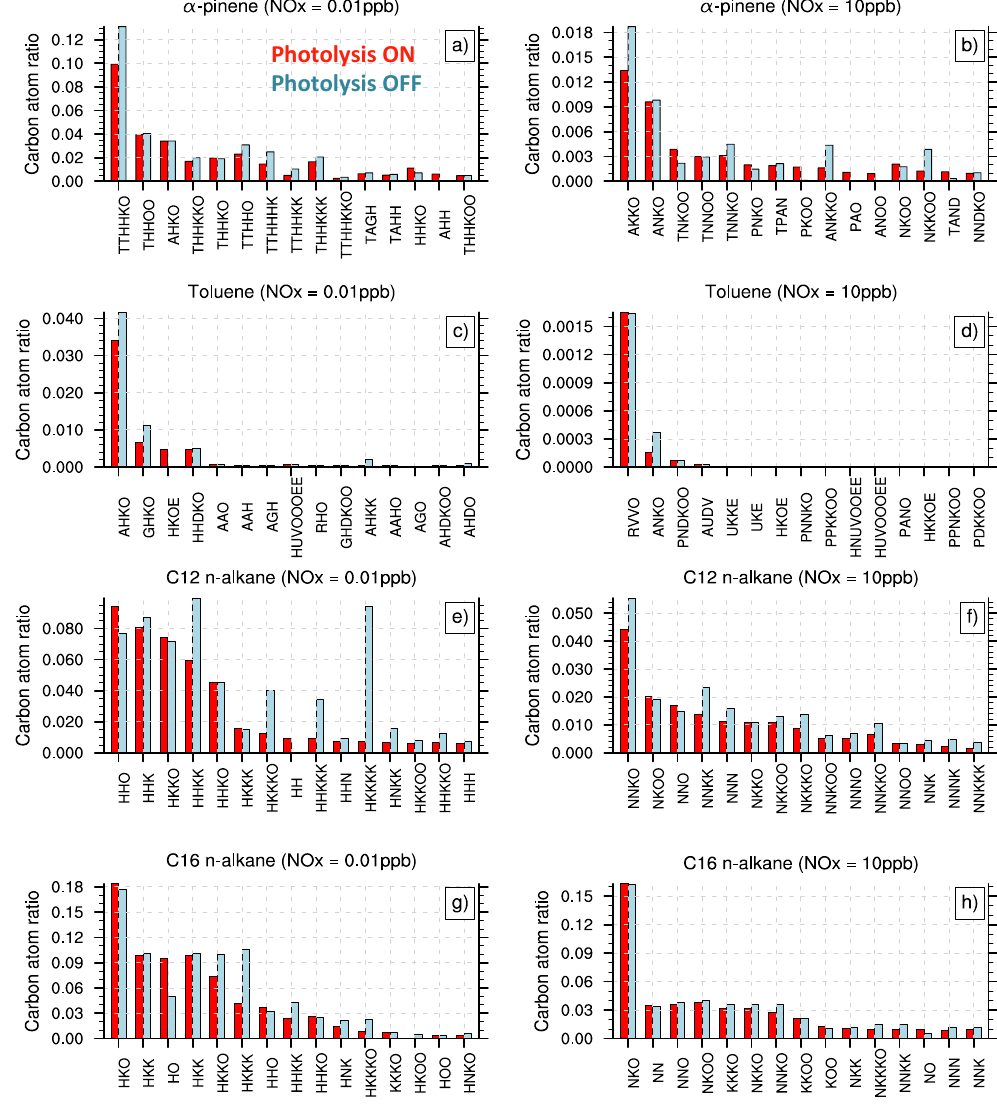
Figure 2. Particle-phase dominant functional groups in the top 15 SOA constituents shown at the maximum of the SOA yield. The BASE case simulations with (red bars) and without (blue bars) photolysis of organic compounds are compared. The carbon atom ratio indicates the ratio of the carbon atoms in the condensed phase to the initial carbon load included in the parent backbone. The sum of the shown particle-phase constituents is lower than 1 as the rest of the carbon mass is in the gas